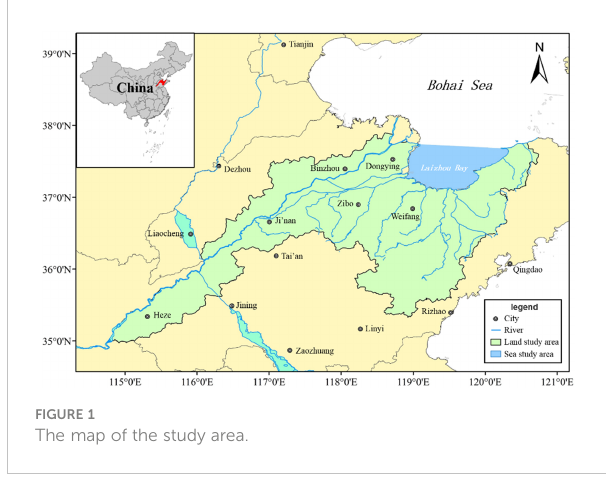
FIGURE 1 The map of the study